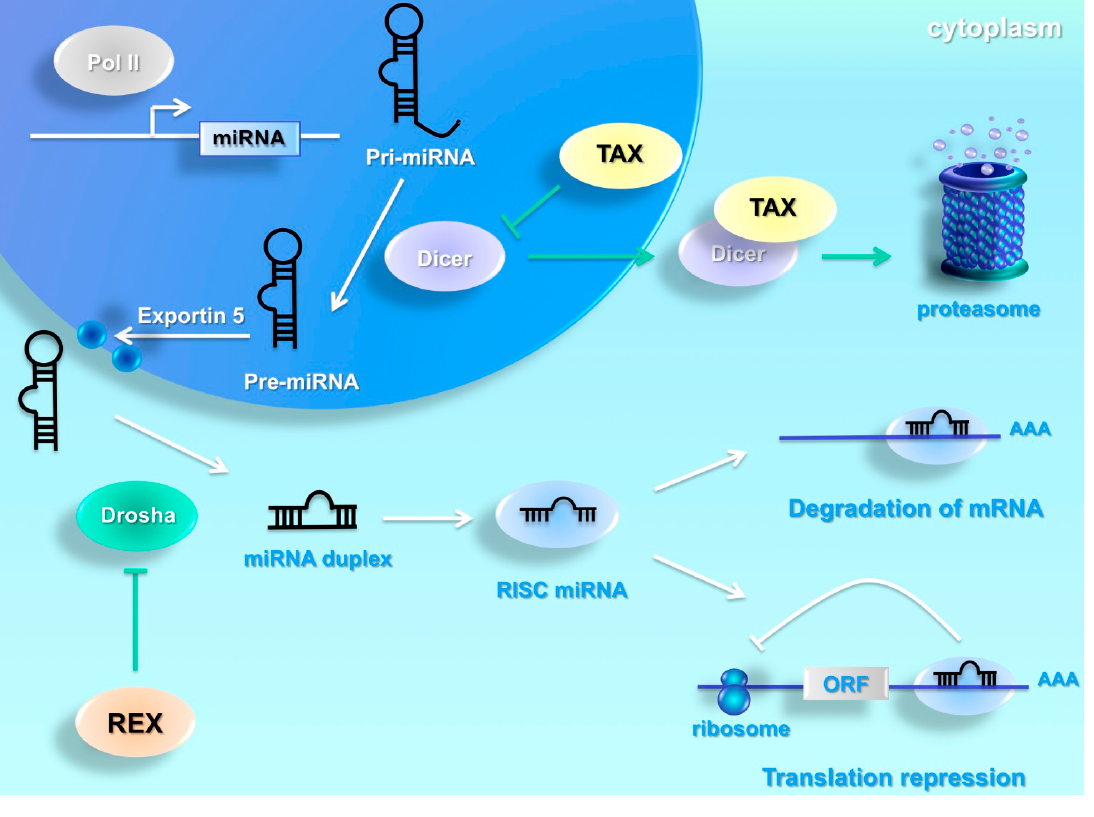
Figure 1. Human T-cell leukemia virus HTLV-1 interferes with cellular miRNA machinery. MiRNAs are transcribed by the RNA polymerase II or III into the nucleus as primary miRNAs (pri-miRNAs) from coding or non-coding part of genes. The nuclear RNase III Drosha recognized and processed pri-miRNAs into a hairpin-shaped RNA, named precursor miRNAs. Pre-miRNAs are transported to the cytoplasm by Exportin 5, and processed by the cytoplasmic RNase III Dicer in the mature miRNA duplex. The duplex forms a complex named RNA-Induced Silencing Complex (RISC). MiRNAs bind complementary sequences usually localized at 3 ′ UTR of messenger RNA and this binding results in the inhibition of translation and/or messenger RNA degradation. HTLV-1 deregulates the cellular miRNA pathway by suppressing the function of Drosha and Dicer.